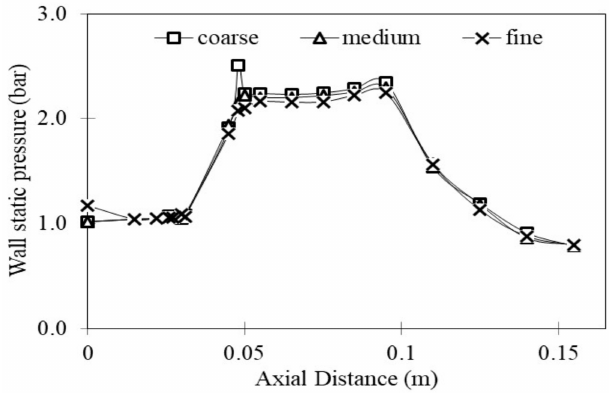
Figure 2. Grid convergence study: static pressure across the bottom wall of the